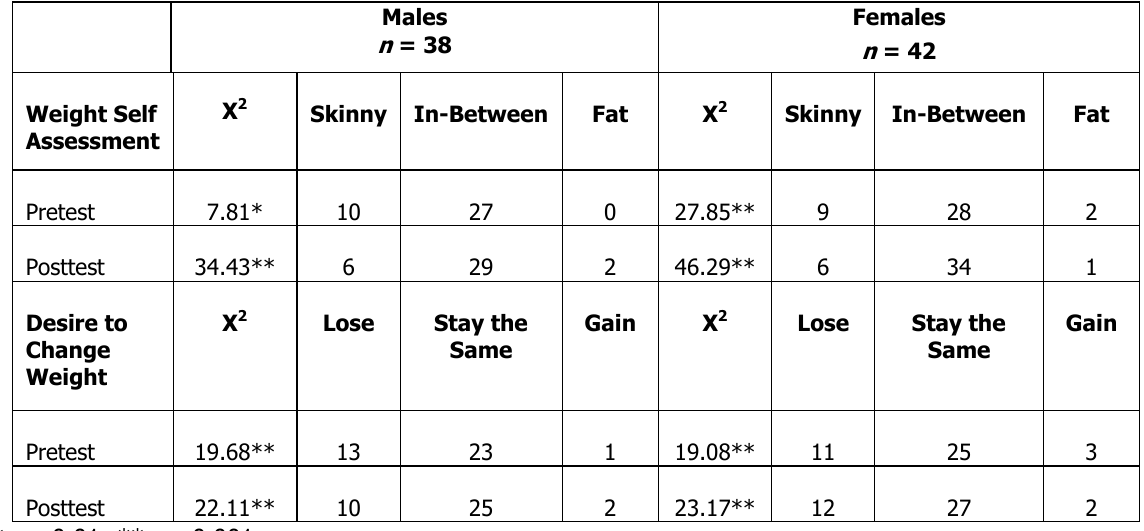
Frequency Distribution of Responses on Weight Self-Assessment